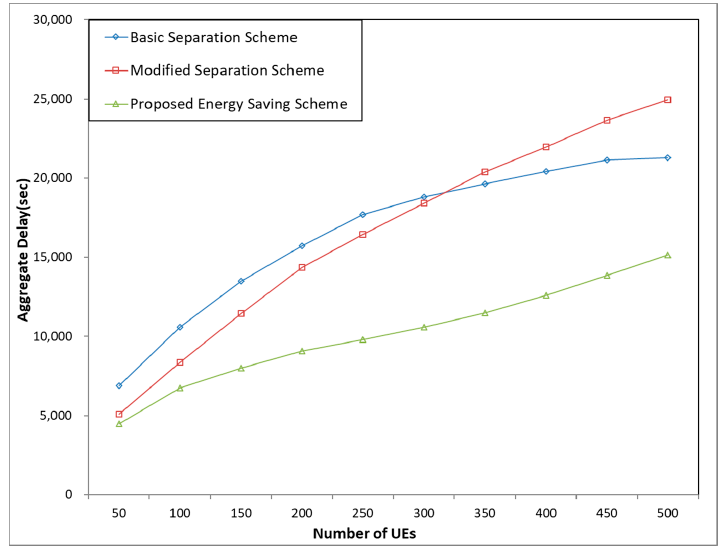
Figure 12. Aggregate delay.